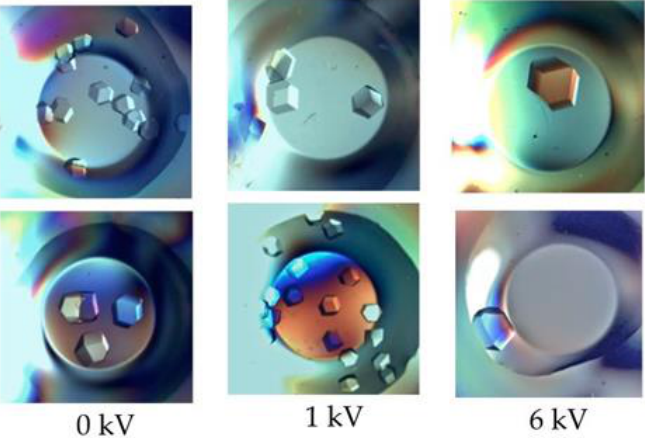
Figure 2. Glucose isomerase crystals grown in the presence of different dc -EFs intensities for 48-h periods [41] (by permission of V. Stojanoff). The top and bottom panels are two typical experimental results.